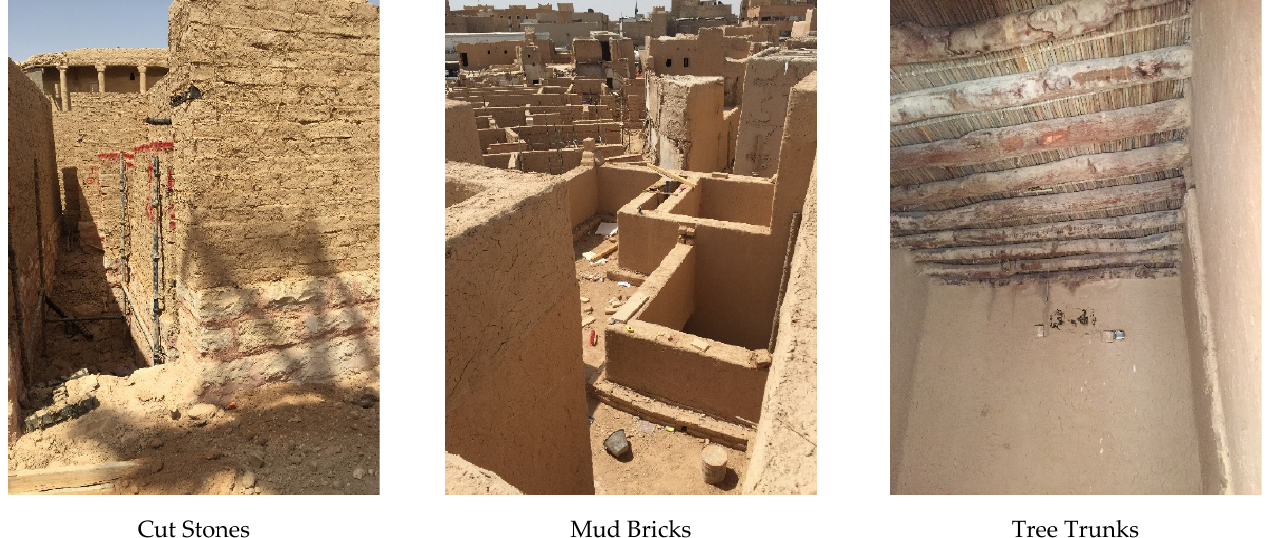
Figure 2. Construction materials used for traditional houses in the Najd Area.